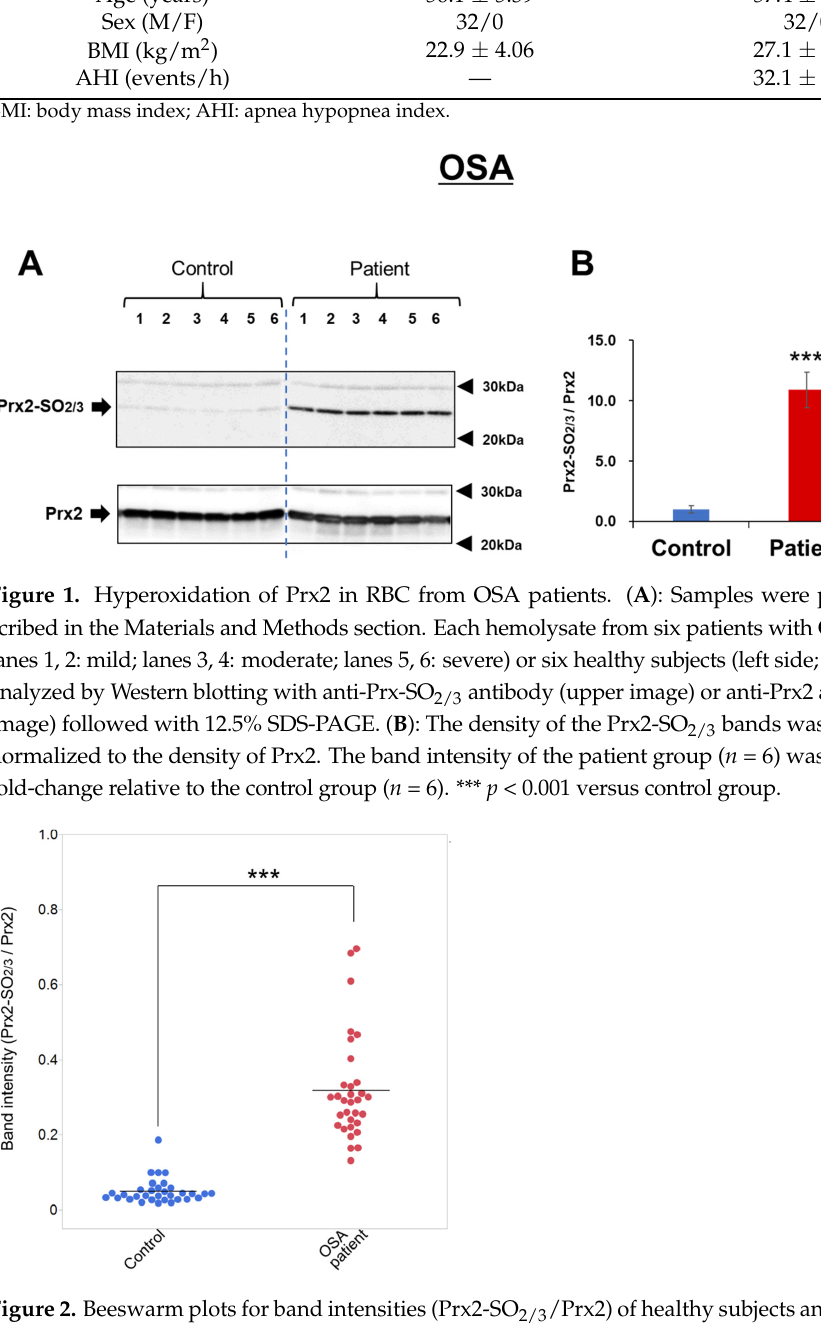
Figure 3. Correlation between the band intensities of Prx2-SO 2/3 and AHI, age, and BMI correspond- ing to each patient with OSA. The band intensity of patients with OSA ( n = 32) was expressed as the normalized ratio of density (Prx2-SO 2/3 /Prx2). AHI was measured using a polysomnography test. BMI was calculated using a person’s height and weight (kg/m 2 ). A: correlation between band inten- sity and AHI; B: correlation between band intensity and age; C: correlation between band intensity and BMI.